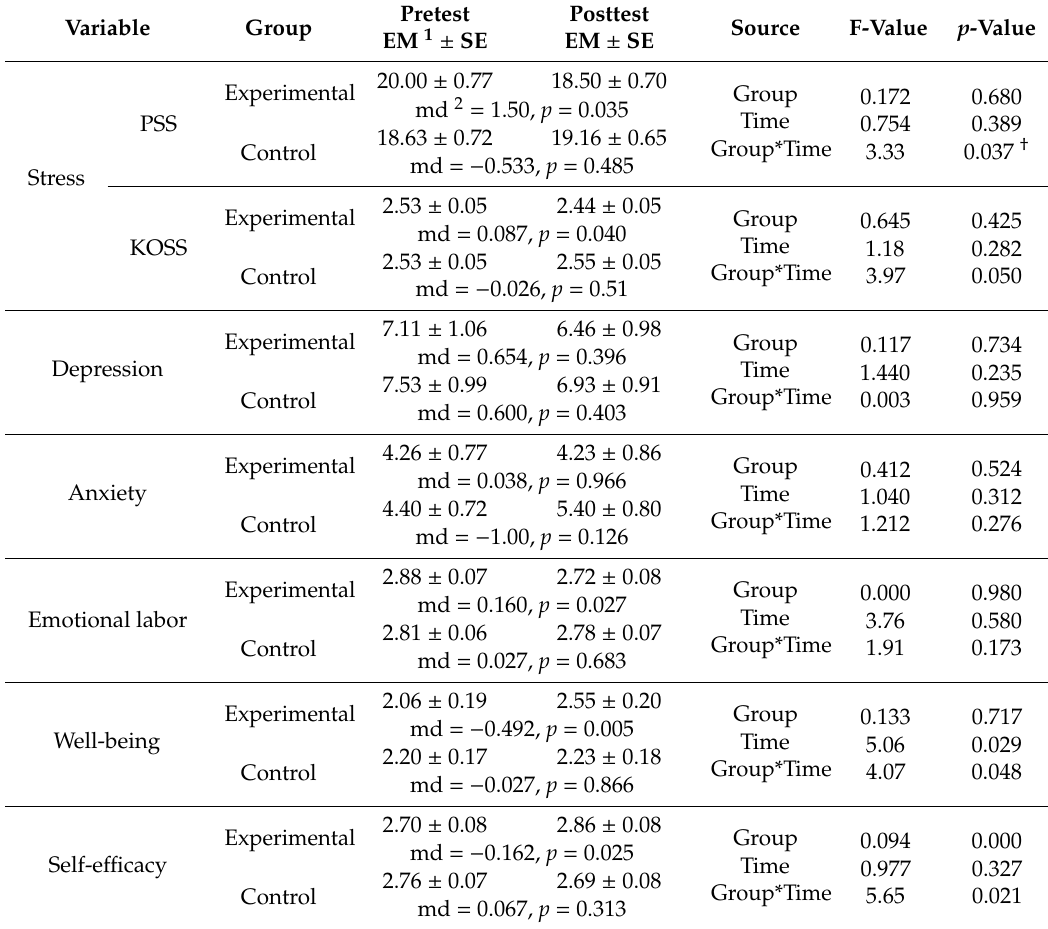
Table 3. The di ff erence of the experimental and control group results. Table 3. The difference of the experimental and control group